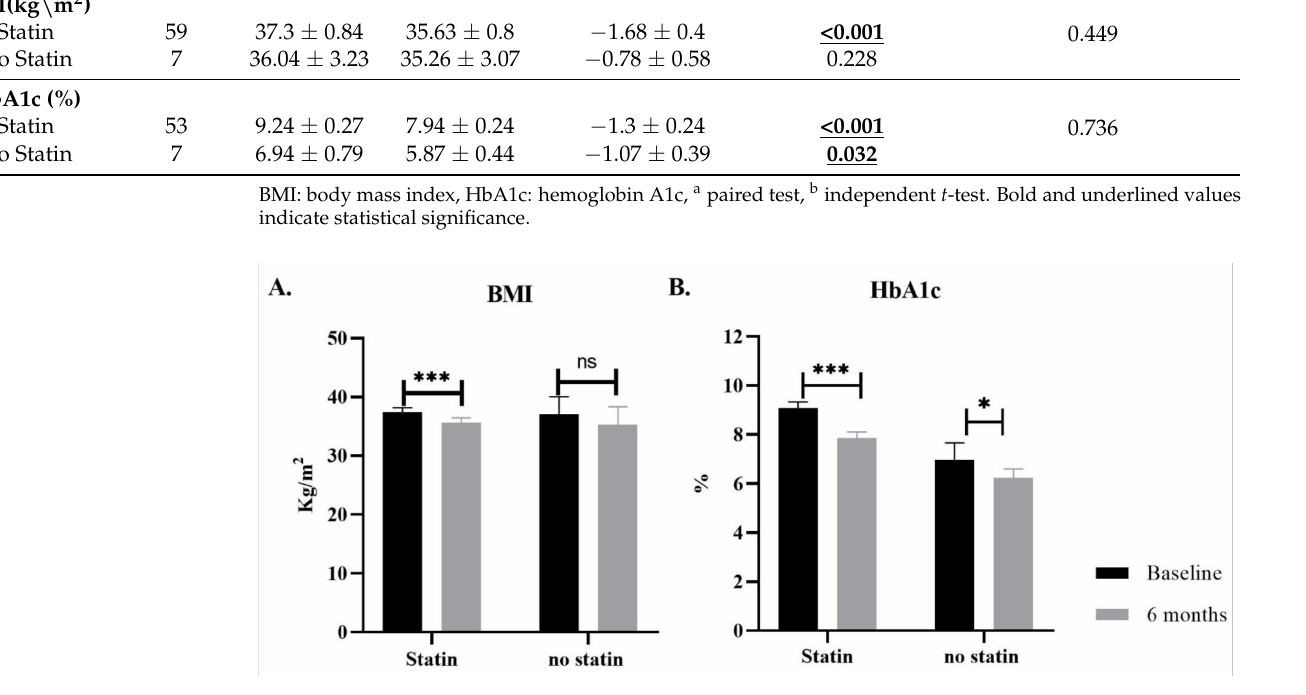
Figure 2. Bar graph representing the effect of GLP-1RA treatment on BMI and HbA1c in diabetic patients. Two groups of diabetic patients received GLP-1RA treatment for six months. Alongside their regular diabetes management medication, the first group of patients was on an antihyperlipidemic drug (Statin), and the 2nd group was not. ( A ) The effect on BMI significantly decreased only in the group taking statins. ( B ) GLP-1RA treatment has an effect of HbA1c on both groups, the effect more significant in the statin group. Data presented as mean ± SEM, *** p -value ≤ 0.001, * p -value ≤ 0.05., ns: